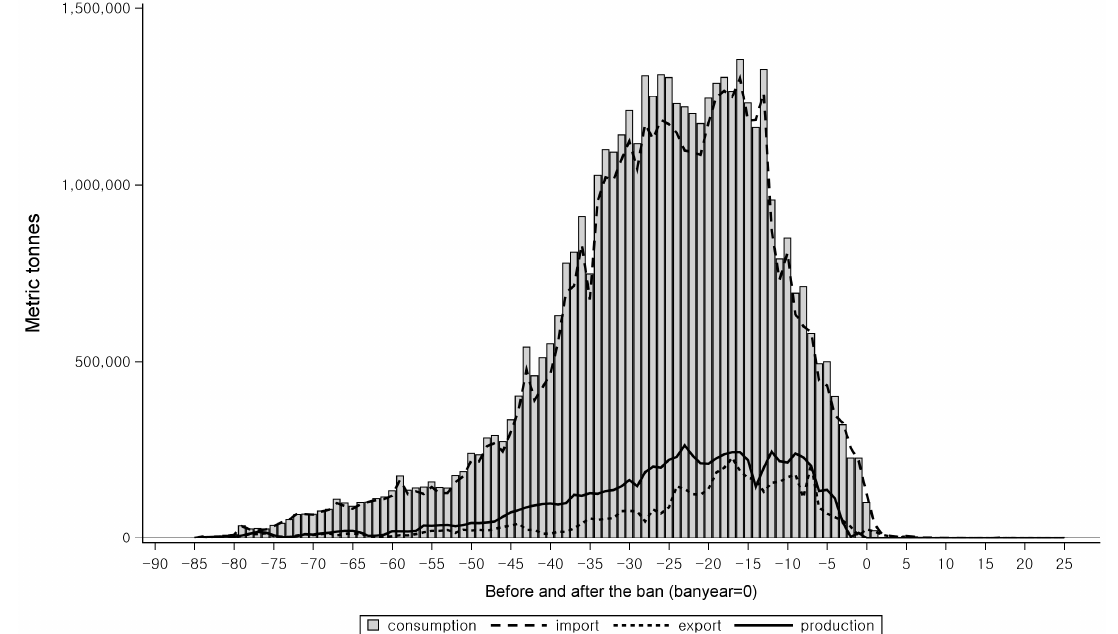
Figure 4. Crude asbestos production, import, export, and consumption among high-income banned countries from 1920 to 2011. Different calendar years were adjusted to year 0 for all the countries with an asbestos ban.